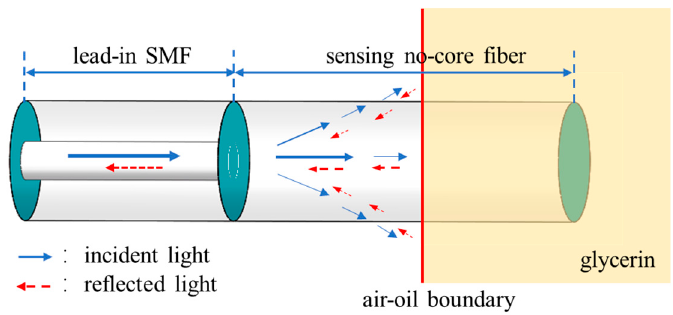
Figure 2. Schematic of the operation mechanism of a liquid-level sensor.